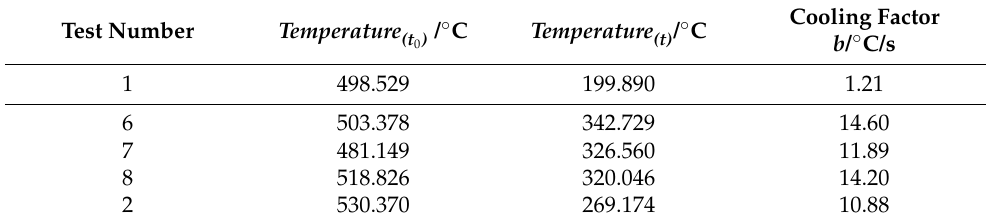
Table 8. Nitrogen injection cooling efficiency at different injection pipe diameters.